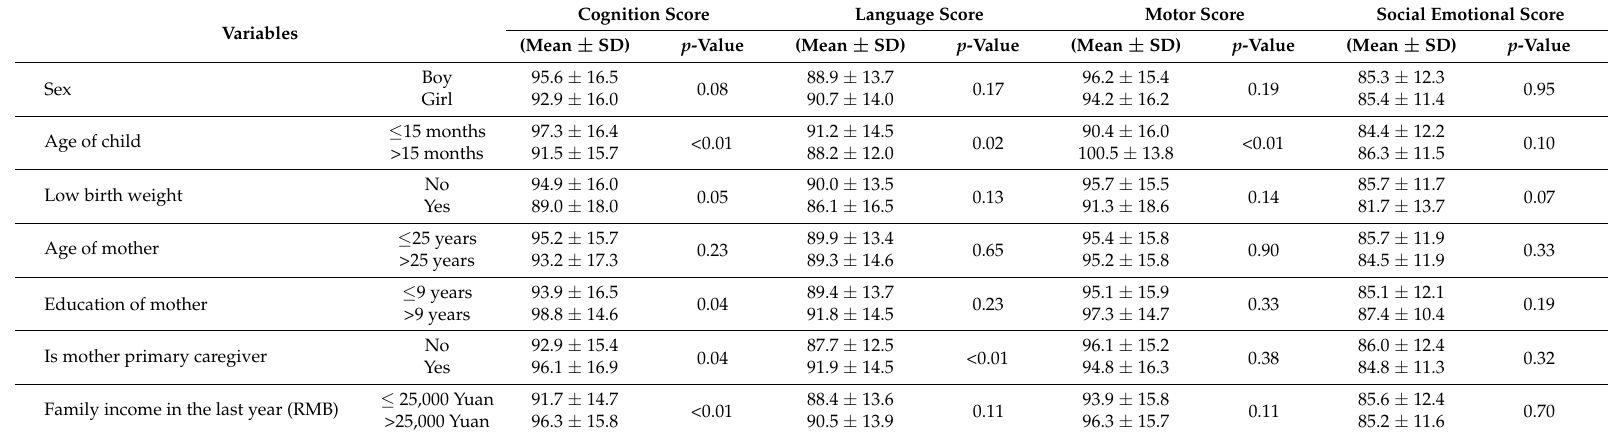
Table 2. Comparison of child development by socioeconomic characteristics of sampled